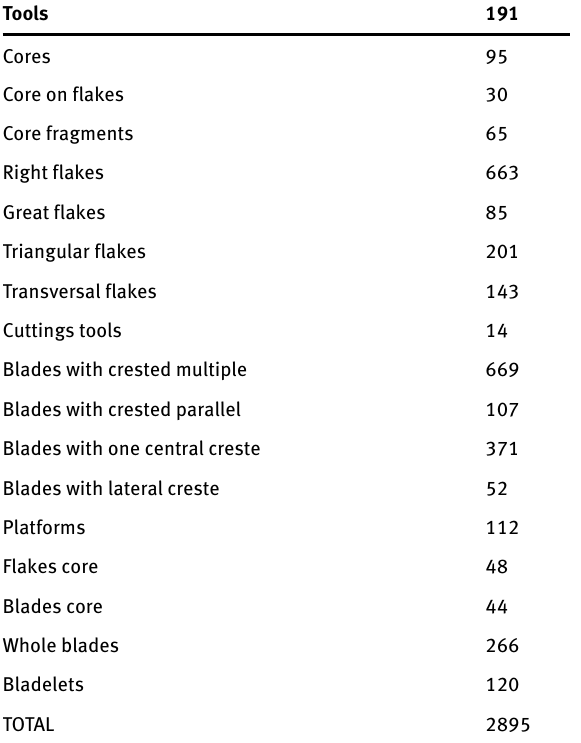
Table 2. Lipari, Contrada Diana trench XVII. Quantity of artifacts reaching the third stage of debitage.